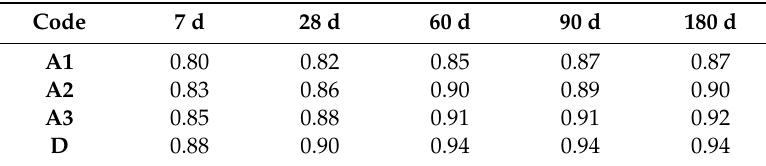
Table 6. The softening coefficient at different ages.